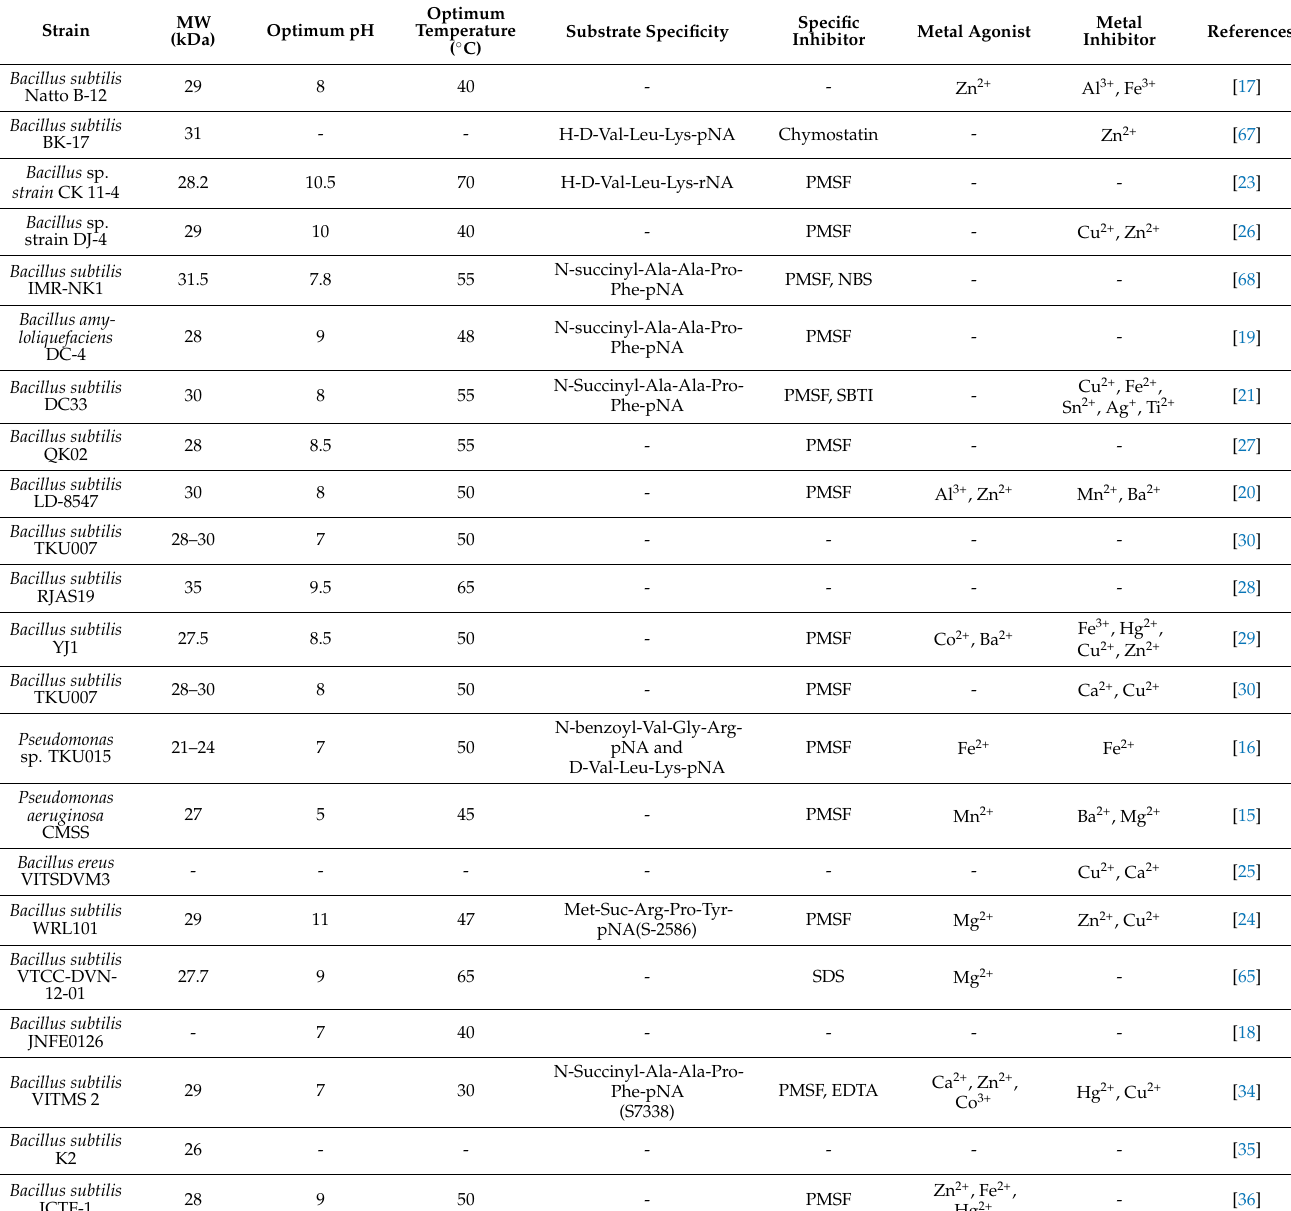
Table 4. Enzymatic properties of nattokinase from different